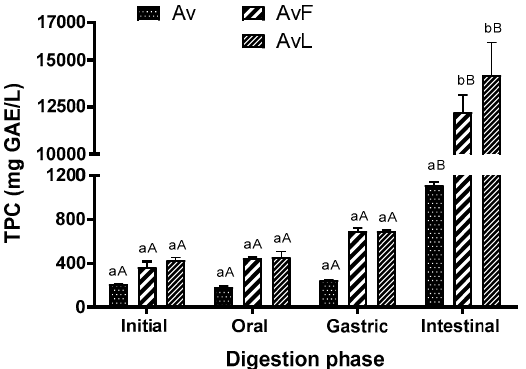
Figure 2. Total phenolic content of non-fermented and fermented Aloe vera juice at the digestion stages. Av : Digestion of non-fermented Aloe vera extract; AvF : Digestion of Aloe vera extract fermented with E. faecium ; AvL : Digestion of Aloe vera extract fermented with L. lactis . Data bearing different lowercase letters (a,b) in the same digestion phase are significantly different ( p < 0.05). Data bearing different capital letters (A, B) in the same sample groups are significantly different ( p < 0.05).